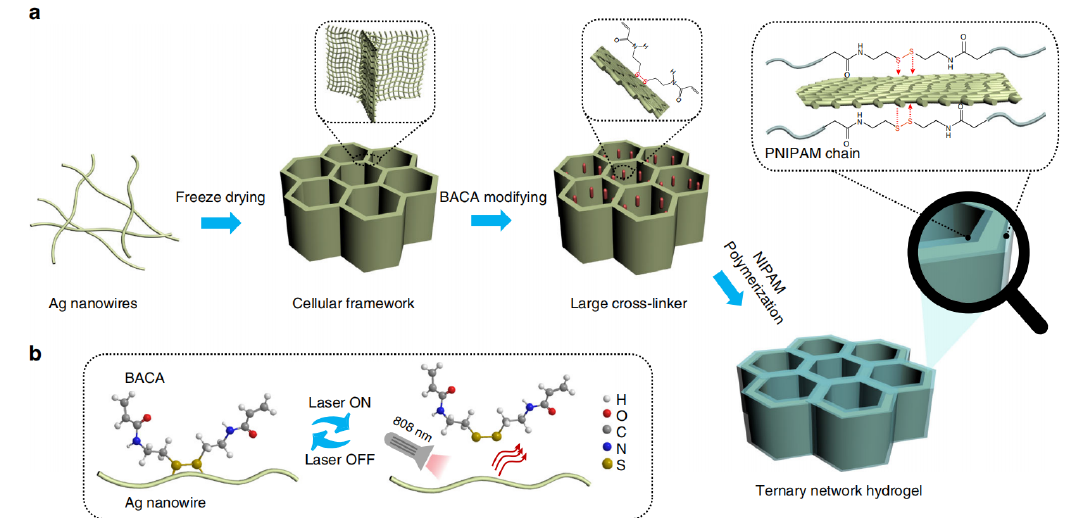
Figure 4. Struture design and self-healing mechanism. ( a ) Schematic illustrations of the preparation of AATN hydrogel. Typically, AgNW aerogel with cellular structure was prefabricated by the freeze- drying method. Being modified with BACA molecules, AgNW aerogel was used as large cross-linker for the synthesis of AATN hydrogel. ( b ) Schematics of the dynamic Ag-RS interaction between BACA and AgNWs under the NIR laser on/off. Reprinted with permission from [69]. Copyright 2018 Springer